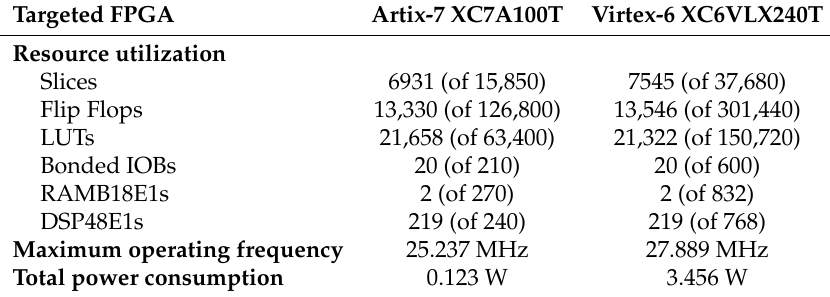
Table 1. Resource utilization, maximum operating frequency, and total power consumption obtained for the Artix-7 XC7A100T and Virtex-6 XC6VLX240T chips, as reported by the Xilinx ISE 14.7 tool. Each FPGA slice contains four LUTs (look-up tables) and eight flip-flops. Each DSP48E1 slice includes a 25 × 18 multiplier, an adder, and an